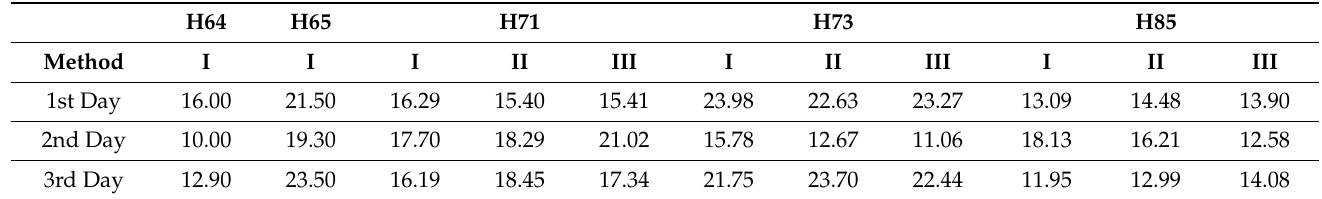
Table 7. Statistical analysis of the forecasting MAPE (%) values of the outputs.